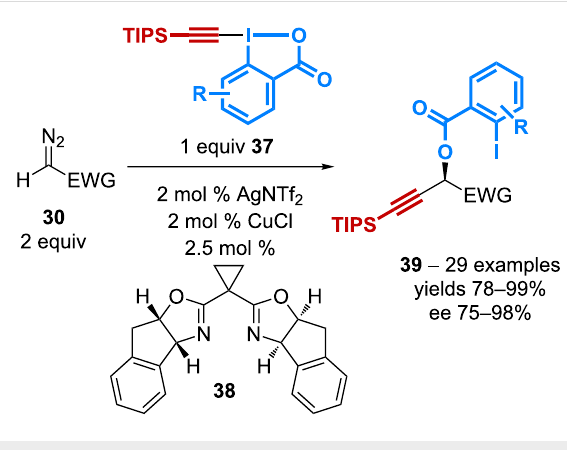
Scheme 12: Catalytic asymmetric benzoyloxy-alkynylation of diazo